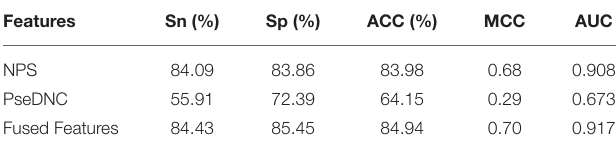
TABLE 1 | Comparison of single feature and fused features.